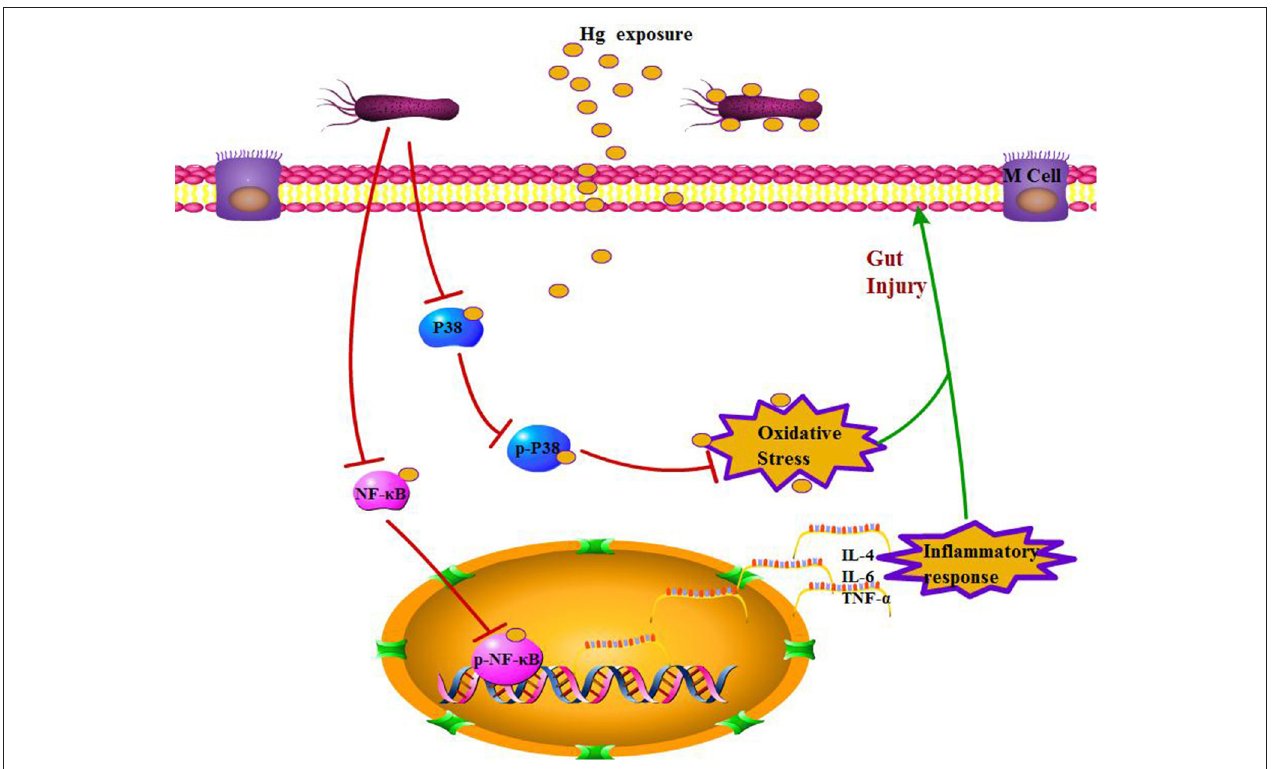
FIGURE 6 | Potential mechanism of L. brevis 23017 probiotic effects against Hg-induced gut